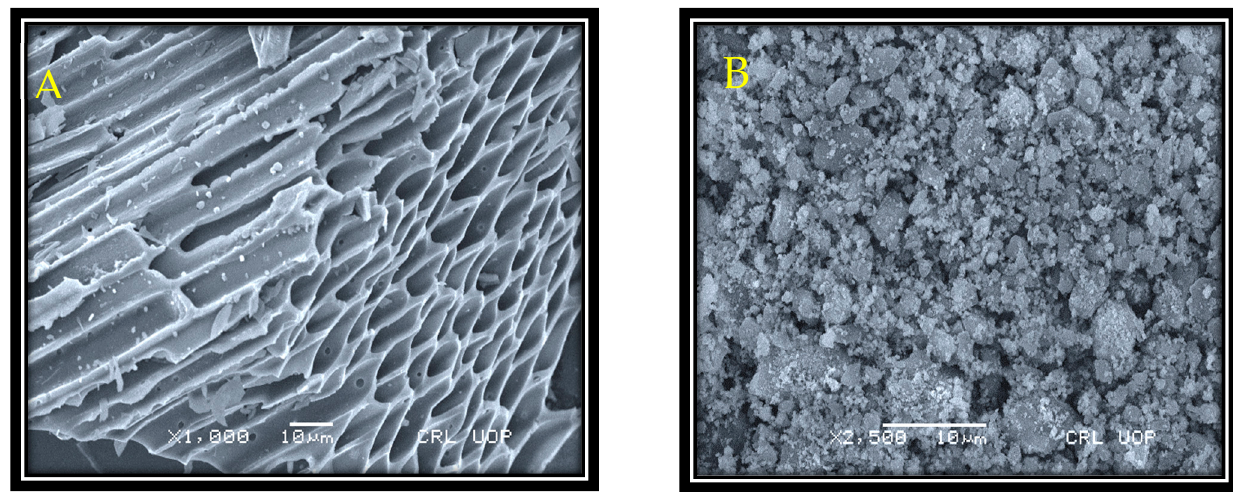
Figure 1. SEM images of pristine biochar ( A ) and MB-ZnO ( B ).